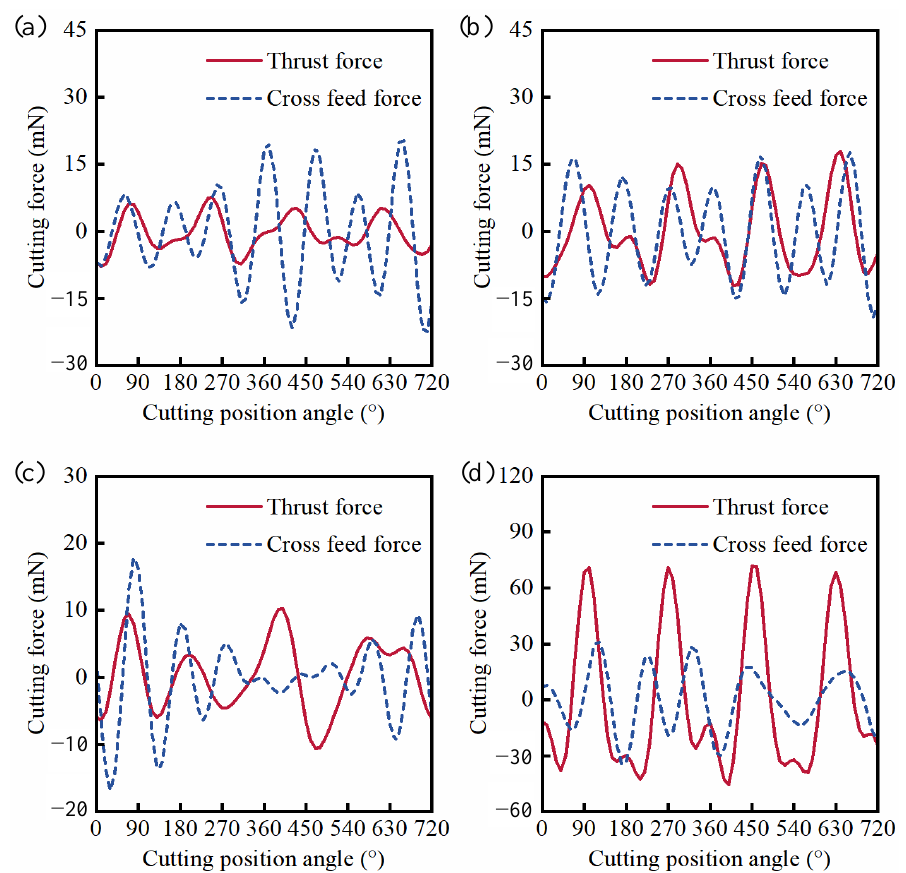
Figure 8. (Scratched surface) Experimental results of cutting force with cutting edge rotation angle under f t / r e : ( a ) f t = 0.27 µ m/z, f t / r e = 0.15; ( b ) f t = 0.46 µ m/z, f t / r e = 0.25; ( c ) f t = 1.37 µ m/z, f t / r e = 0.75; ( d ) f t = 5.46 µ m/z, f t / r e = 3.0.